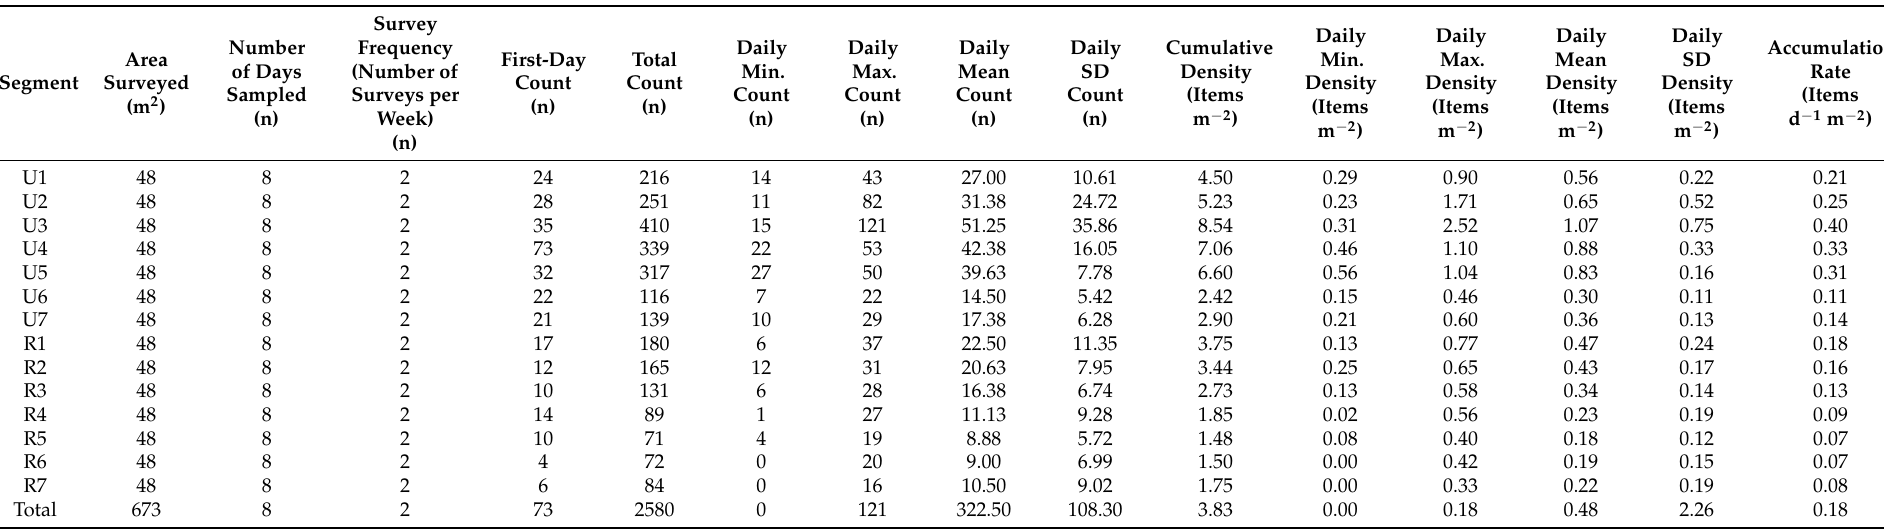
Table 2. Summary of macroplastic surveys including the item counts, densities (items m − 2 ), and accumulation rates (items d − 1 m − 2 ) in sampling sites of